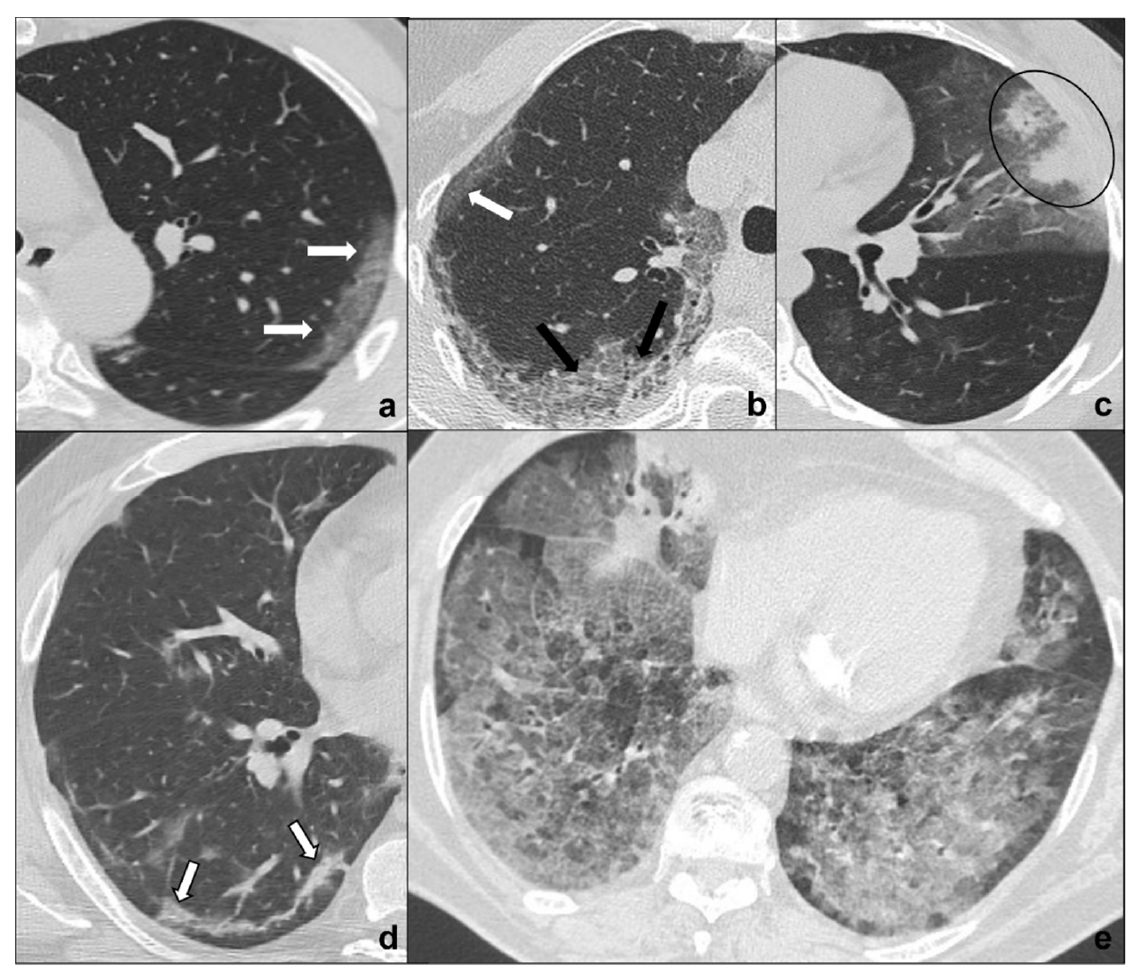
Figure 1. ( a – e ) HRTCs showing the four different stages of COVID-19 pneumonia ( a – d ) and ARDS as a possible complication I. In ( a ), the first stage is characterized by subpleural ground-glass opacities (white arrows in ( a , b )) which co-exist with extensive subpleural crazy paving pattern in stage 2 (black arrows in ( b ); in ( c ), consolidations (black circle) are typical of phase 3 and may be surrounded by ground-glass opacities; in ( d ) parenchymal bands (black-bordered white arrows in ( d ) are character- istic of the absorption phase); in e, confluent ground glass opacities with dependent foci of consoli- dations represent a dire complication of COVID-19 pneumonia: acute respiratory distress syn- drome. Lungs: mean window with 1500 HU; mean window level − 600. Mediastinum: mean window with 350 HU; mean window level 50 HU.